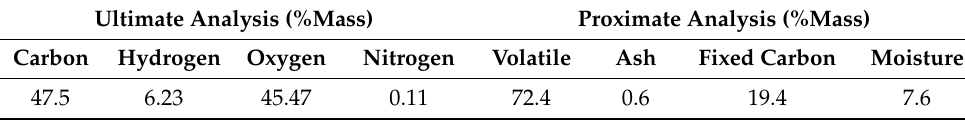
Table 3. Ultimate and proximate analysis results (%adb) *.